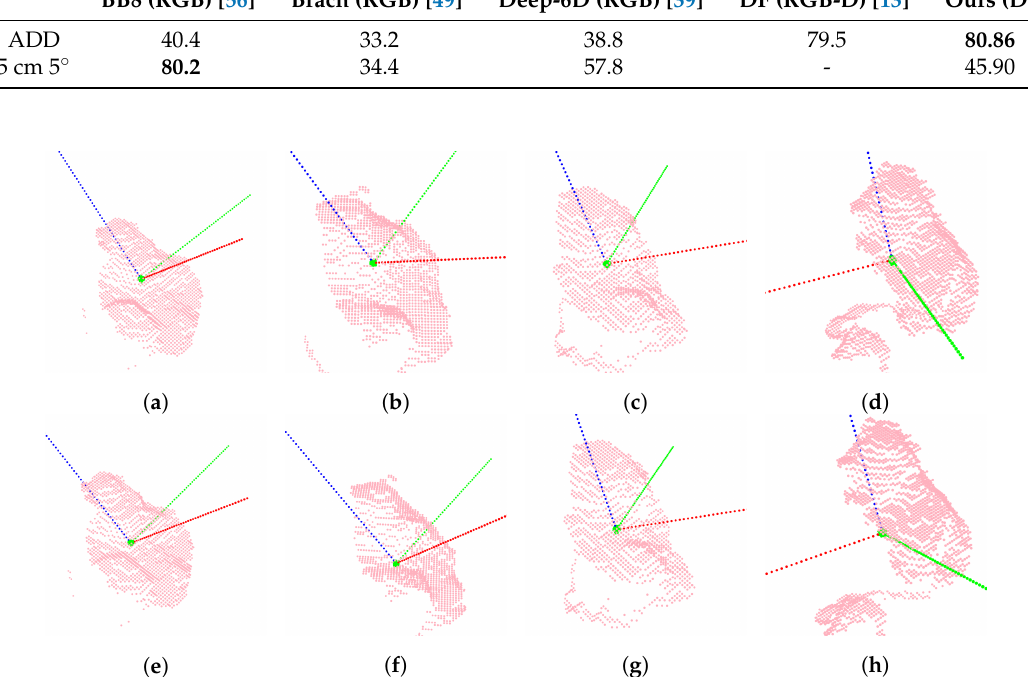
Figure 18. Visualization of object pose. The top row shows ground truth poses, and the bottom row shows predicted